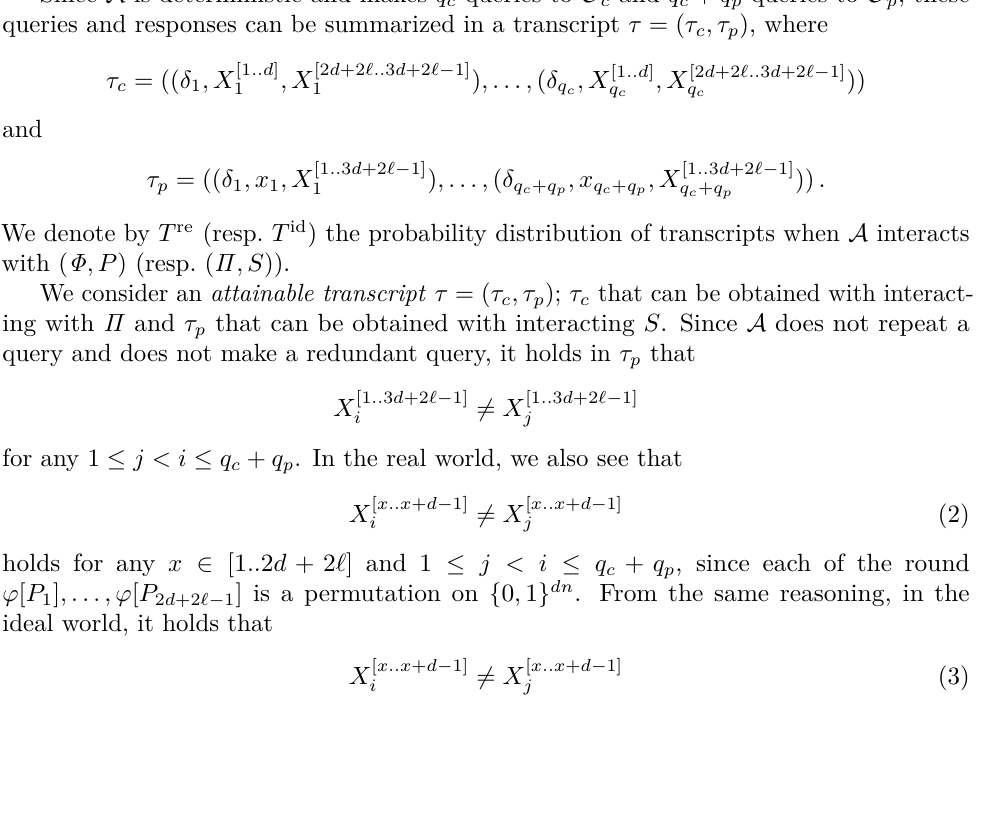
Figure 7: Procedure of Π . The definition is